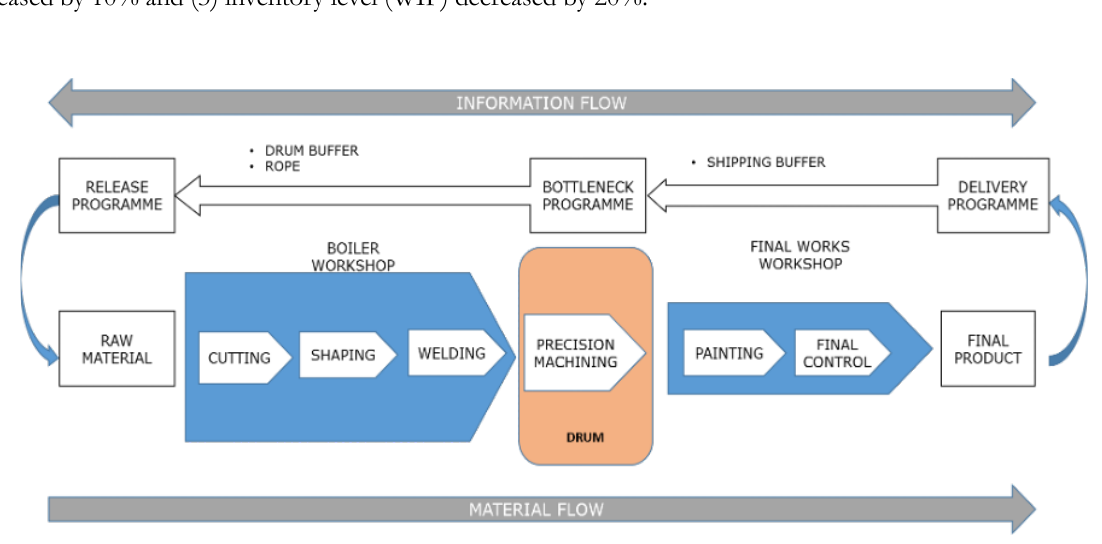
Figure 8. General material flow in the case study company (Lizarralde et al.,